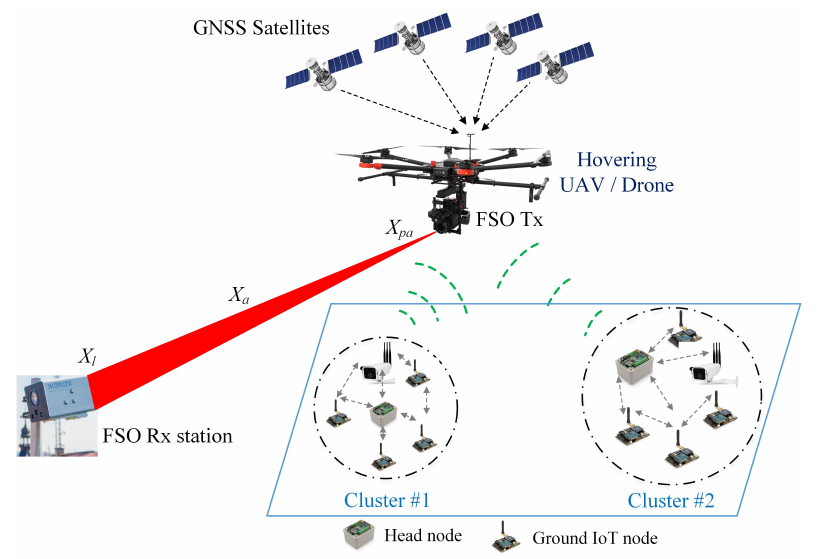
Figure 1. A proposed UAV-based free-space optical communication